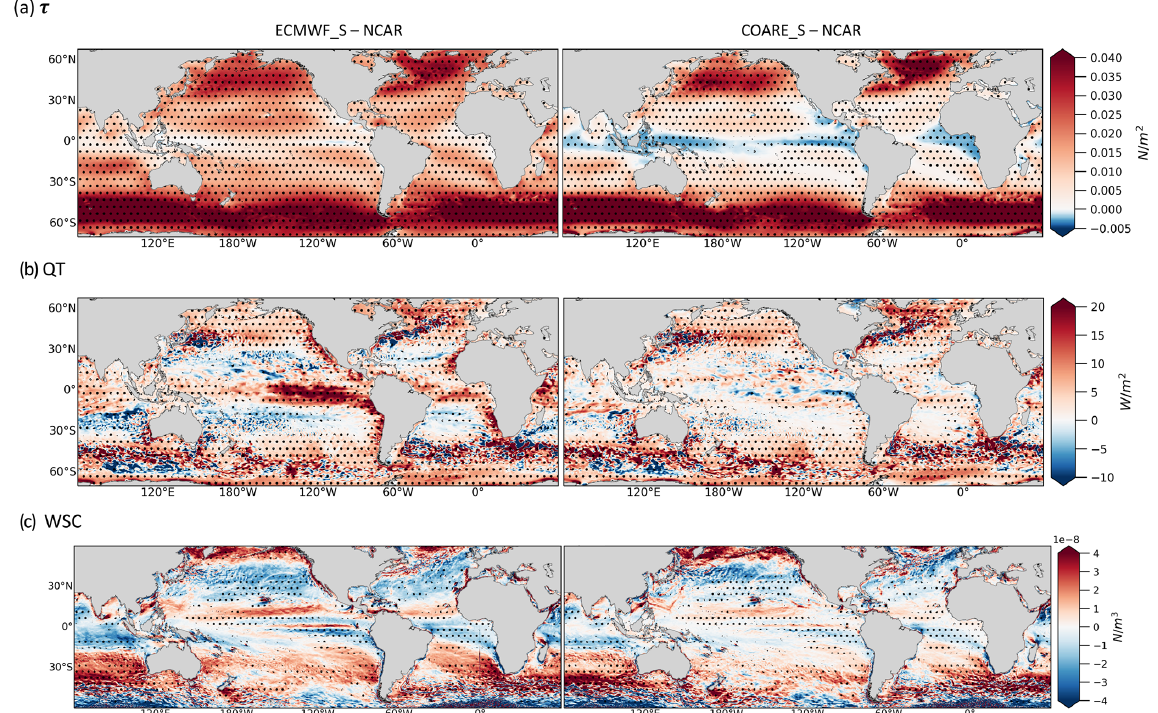
Figure 3. Annual mean differences between ECMWF_S and NCAR experiments (left) and between COARE_S and NCAR experiments (right) in (a) wind stress ( τ ), (b) total turbulent heat flux ( Q T ), and (c) wind stress curl (WSC). Hatching indicates significant values (95% confidence level).